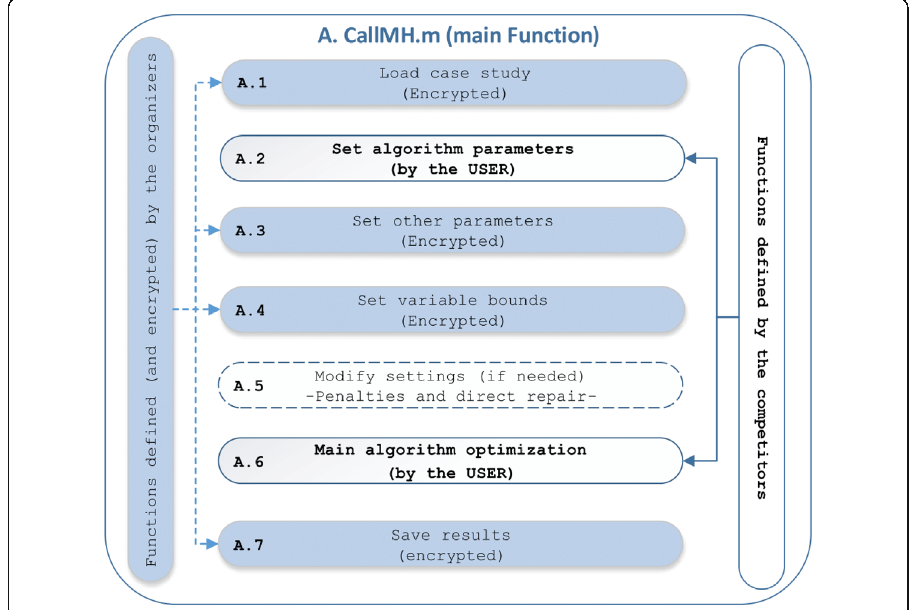
Fig. 1 Overview of the aggregator energy management